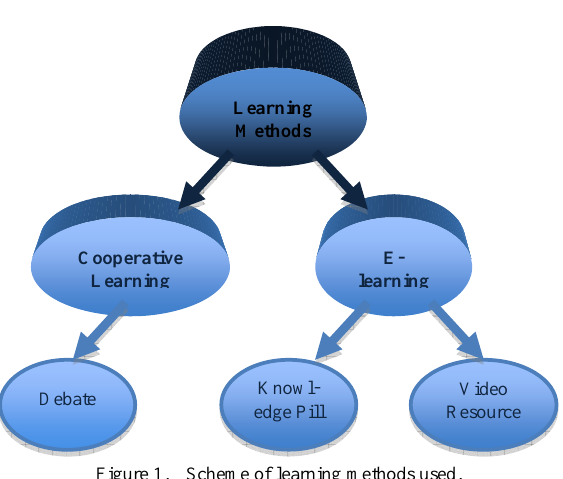
Figure 1. Scheme of learning methods used.